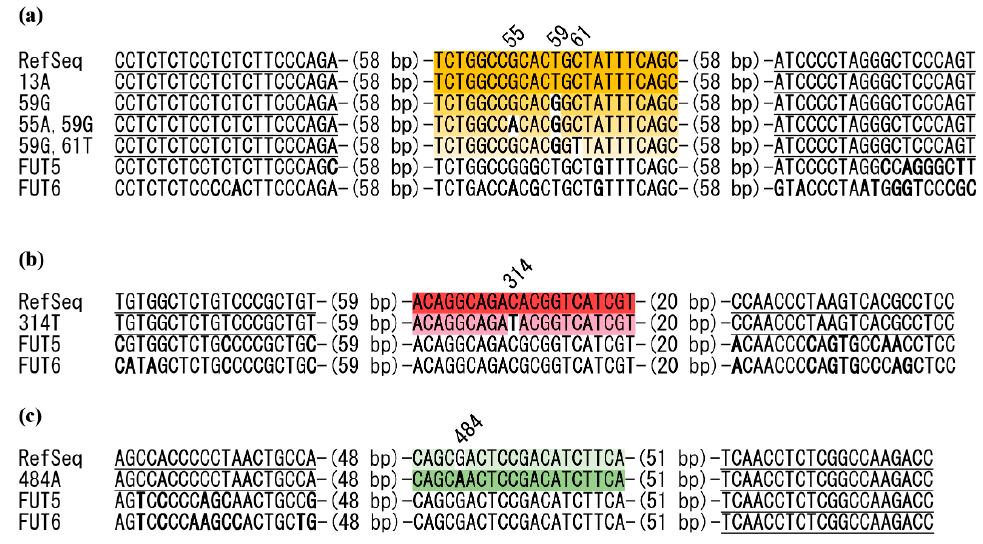
Figure 1. Alignment of DNA sequences of three amplicons and dual-labeled probes of the triplex probe-based FMCA for detection of c.59T>G, c.314C>T, and c.484G>A of FUT3 . Reference sequence (RefSeq), derived alleles of FUT3 , and corresponding sequences of FUT5 and FUT6 are aligned. Positions of the SNPs are shown in the upper sequences. Primer sequences are underlined, and dual-labeled probes are shaded green for FAM, yellow for HEX, and red for Cy5. Bold letters indicate nucleotides that differ from the reference sequence. ( a ): Alignment of DNA sequences around c.59T>G. In addition to three target SNPs, c.55G>A and c.61C>T are also shown because these sites are polymorphic in the 59T-probe. ( b ): Alignment of DNA sequences around c.314C>T. ( c ): Alignment of DNA sequences around c.484G>A.